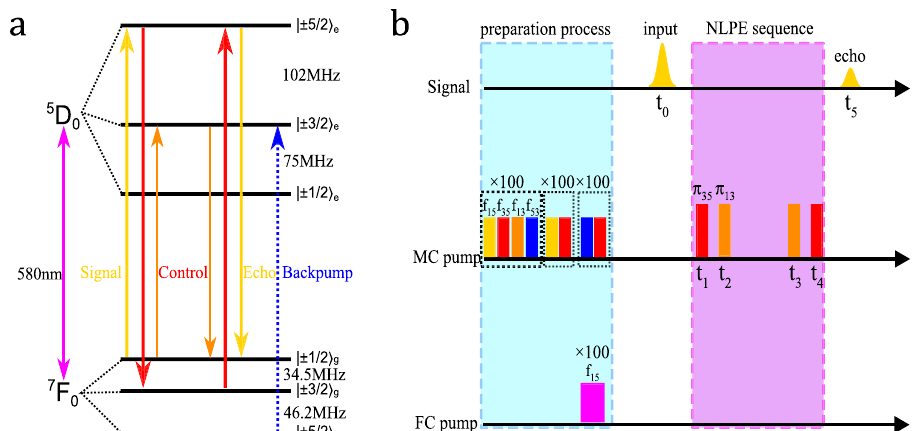
(cid:1) (cid:1) is e